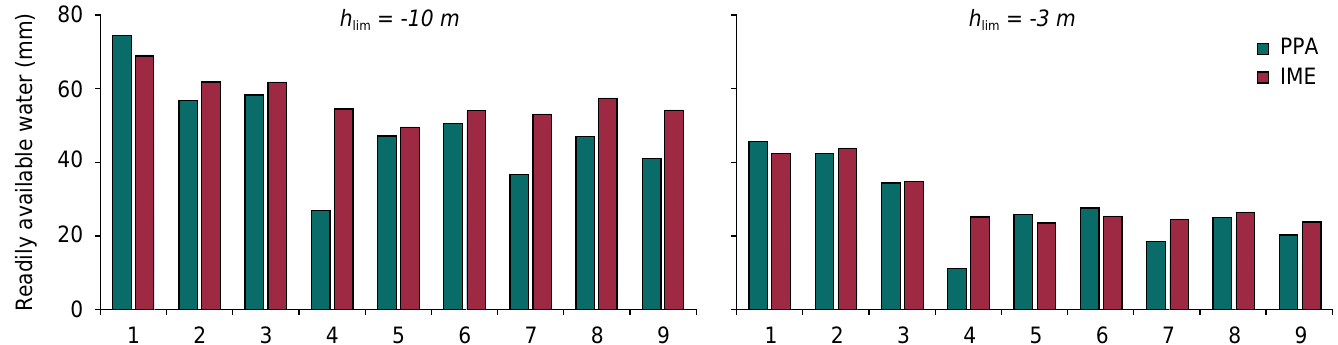
Figure 4. Readily available water estimated for the nine soils using the θ -h relations obtained by inverse modeling of a laboratory evaporation experiment (IME) and by the tension table/pressure plate apparatus (PPA) considering two pressure heads for the onset of drought stress ( h lim